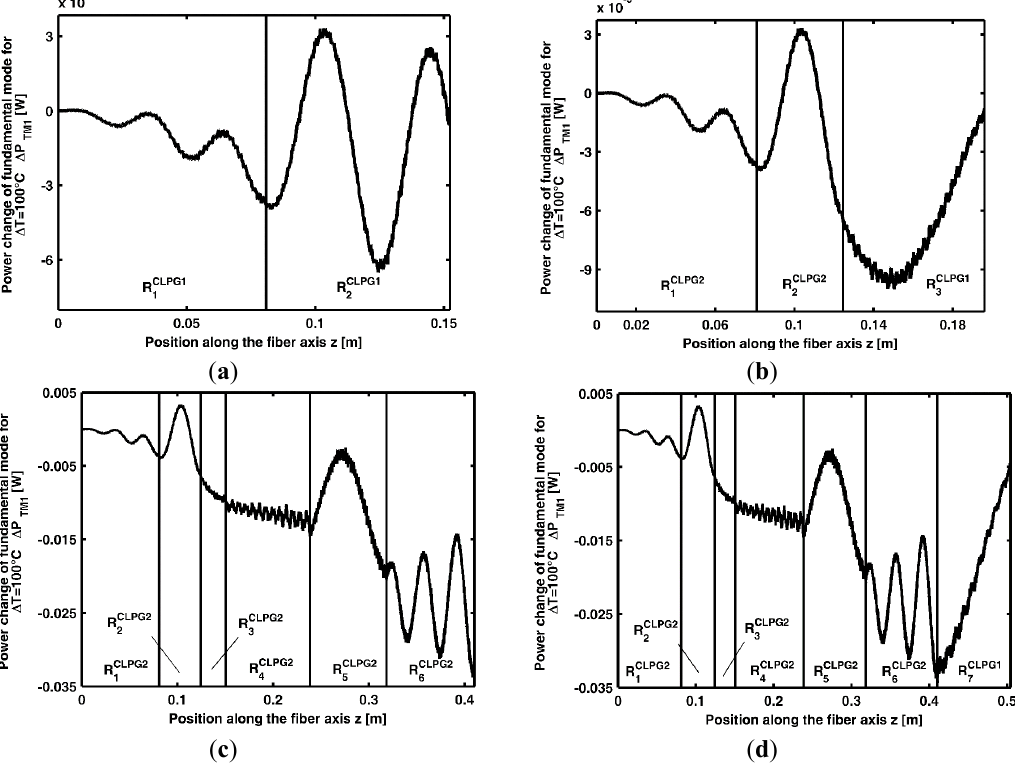
Figure 7. Power change of the M 1 mode, Δ P M1 Δ T , for the temperature variation 0–100 °C, along the grating cascade CLPG 1 .